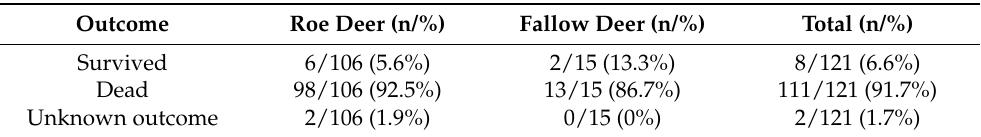
Table 7. Outcome in the ungulates with traumatic skeletal lesions, expressed as the number and proportions (n/%) of roe deer and fallow deer, and total population.